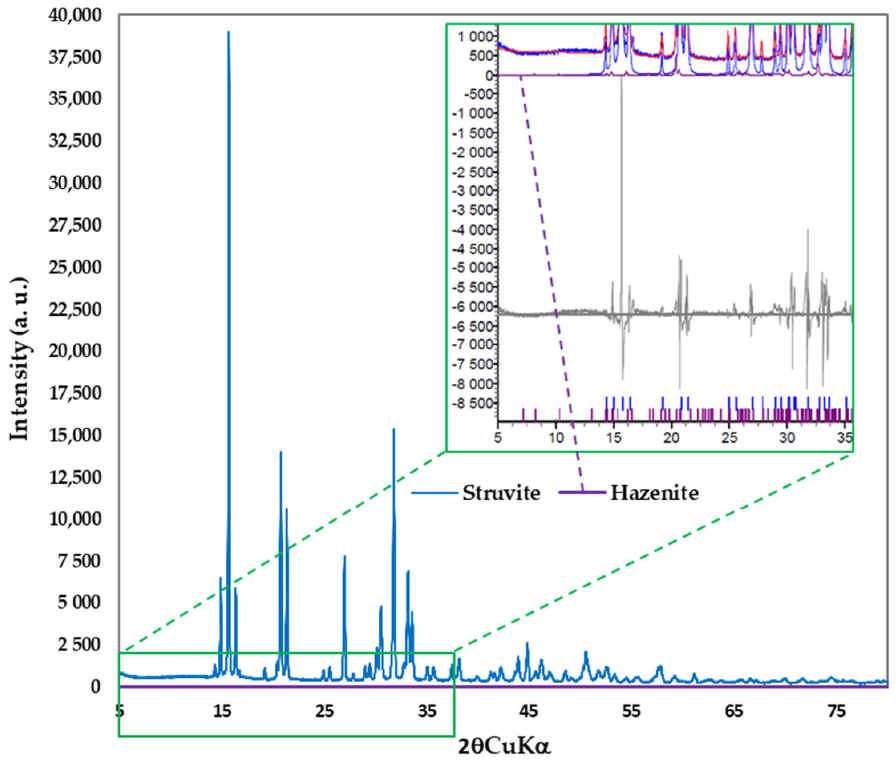
Figure 3. XRD pattern of precipitate Sample 1—molar ratio PO 43- :Mg 2+ 1:1.3. Table 4. Percentages of phase values obtained from precipitates identified using XRD method.